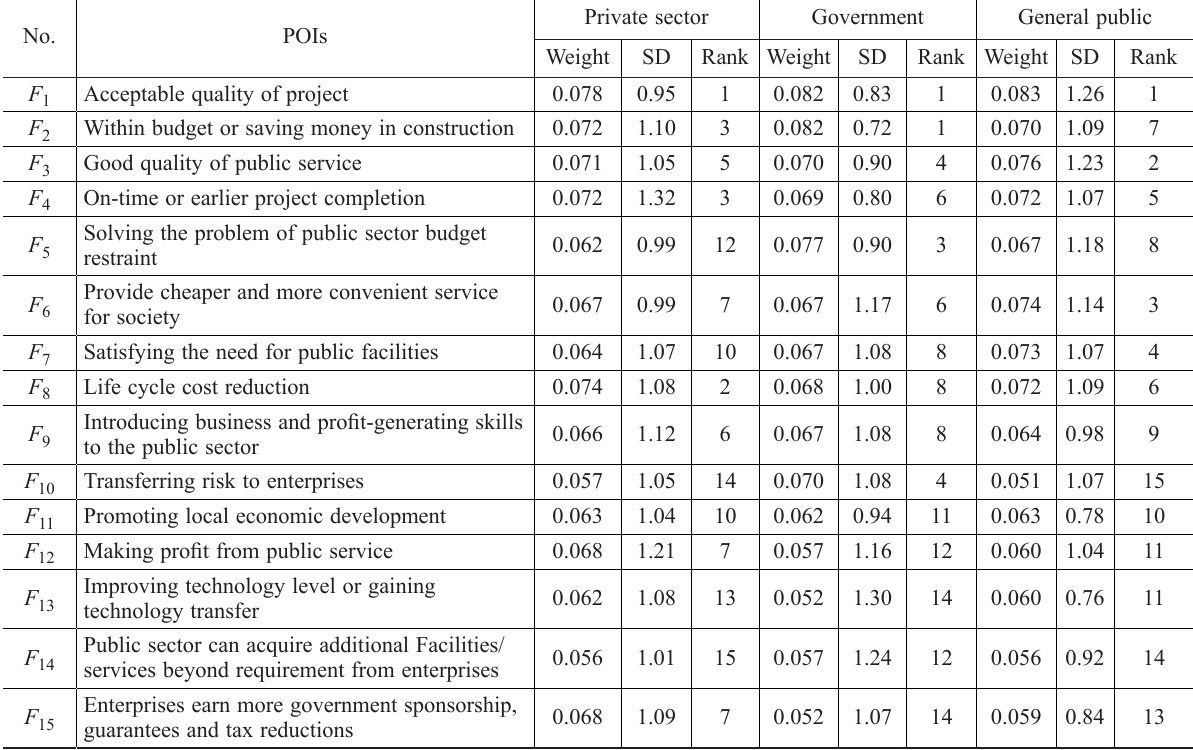
Table 1. Questionnaire survey about POIs of PPP projects